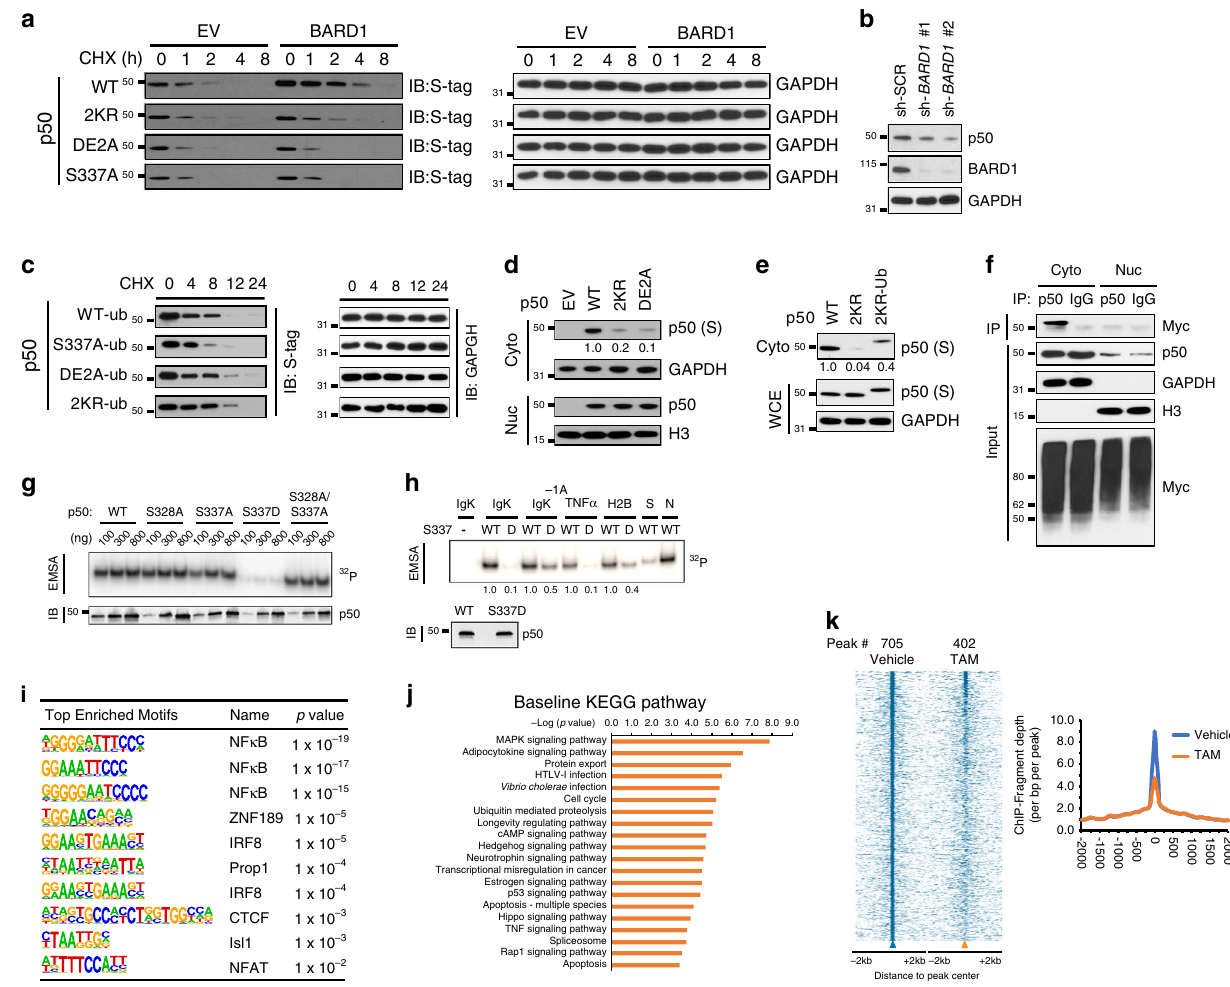
Fig. 5 Mono-ubiquitination stabilizes p50 and decreases chromatin recruitment. a Bard1 -null cells transfected with BARD1 or empty vector (EV) and the indicated S-tag p50 construct. IB performed with anti-S antibody or anti-GAPDH at the indicated time after cycloheximide (CHX) addition. See Supplementary Fig. 4a for quanti fi cation. b 293T cells infected with sh-RNA targeting BARD1 . IB performed with indicated antibody. c Bard1 -null cells transfected with BARD1 and the indicated S-tag p50 construct fused with a C-terminal Ubiquitin (0 K and GG/AA mutant Ub). IB performed at the indicated time after CHX addition. See Supplementary Fig. 4b for quanti fi cation. d 293T cells transfected with the indicated p50 construct were separated into nuclear (nuc) and cytoplasmic (cyto) fractions. IB with anti-S antibody or indicated loading control. e 293T cells transfected with S-tag p50 wt , p50 2KR , or p50 2KR-Ub were fractionated into cytoplasmic (cyto) fraction. Twenty percent of the cell pellet was isolated for analysis of whole-cell extract (WCE). IB was performed with anti-S tag. f 293T cells transfected with Myc-Ub were separated into nuc and cyto fractions. IP in each fraction performed with anti- p50 antibody or anti-IgG and IB with anti-Myc. g Electrophoretic mobility shift assay (EMSA, upper) or immunoblot (IB, lower) of increasing amounts of bacterially expressed p50 wt , or p50 mutant, protein using the IgK probe. The same membrane was analyzed by autoradiography ( 32 P) and IB. h EMSA (upper) or IB (lower) of p50 wt (WT) and p50 S337D (D) protein using the κ B-site probe from the indicated gene (tumor necrosis factor alpha, TNF α ; histone 2B, H2B). IB of input proteins demonstrates equal loading. IgK − 1A is the IgK with adenine at the – 1 position. S and N, speci fi c and non-speci fi c competitor, respectively. i DNA motifs most signi fi cantly enriched for p50 on ChIP-Seq analysis of 293T cells expressing TopBP1 ER treated with vehicle. j Kyoto Encyclopedia of Genes and Genomes (KEGG) pathway analysis of p50 ChIP-seq peaks at baseline ranked by – log10 ( P -value). k ChIP-seq analysis of p50- binding peaks. Heatmap (left) and histogram (right) for average peak intensity was plotted for ChIP-Seq data from vehicle and tamoxifen (TAM) treated samples. All blots are representative of at least two biologically independent experiments. Analysis of fold-change normalized to control lane shown below IB where